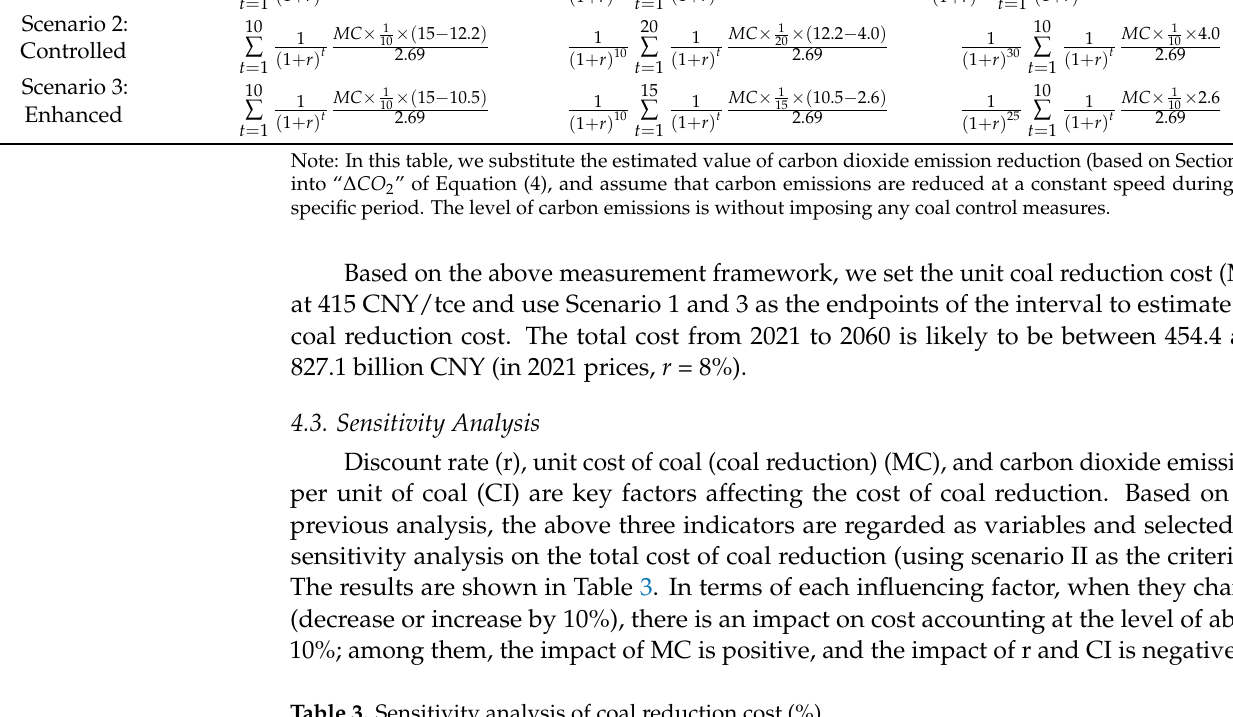
Table 3. Sensitivity analysis of coal reduction cost